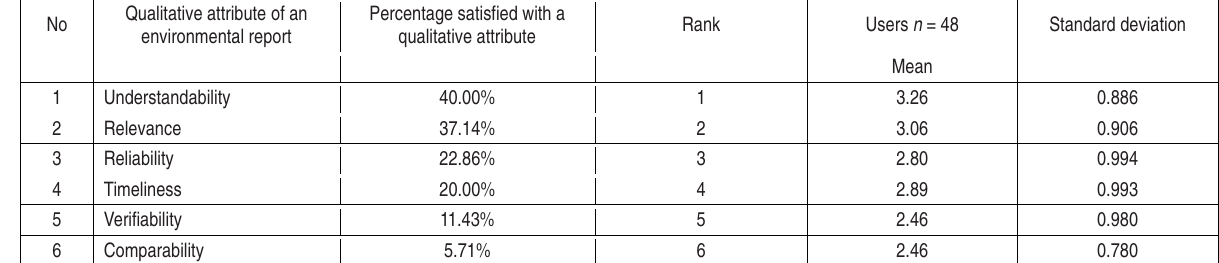
Table 5. Users’ satisfaction with the qualitative attributes of environmental